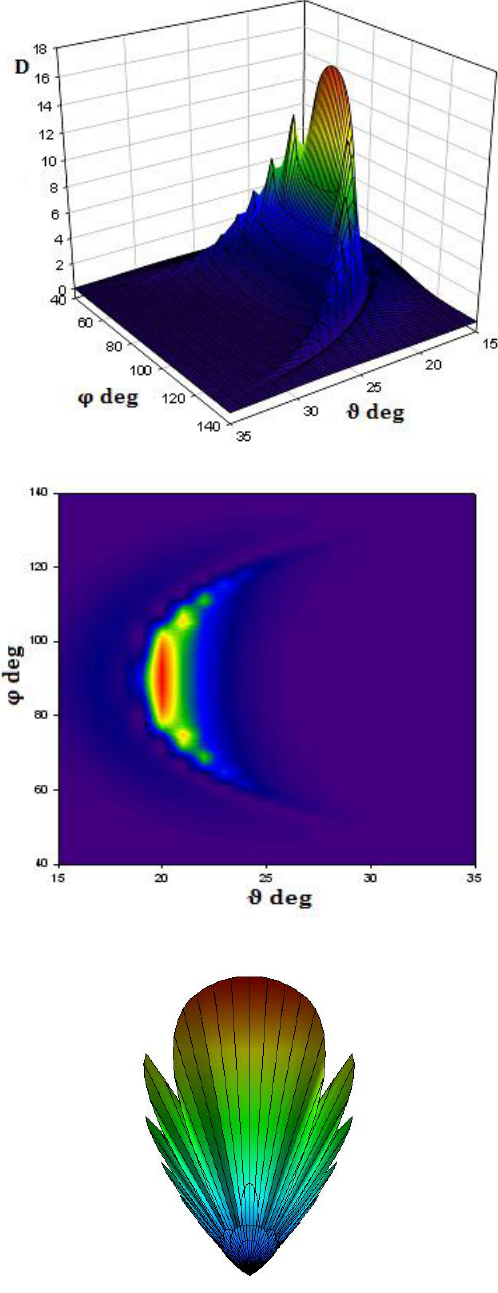
Figure 7a: The pattern of reflected field f =37,2